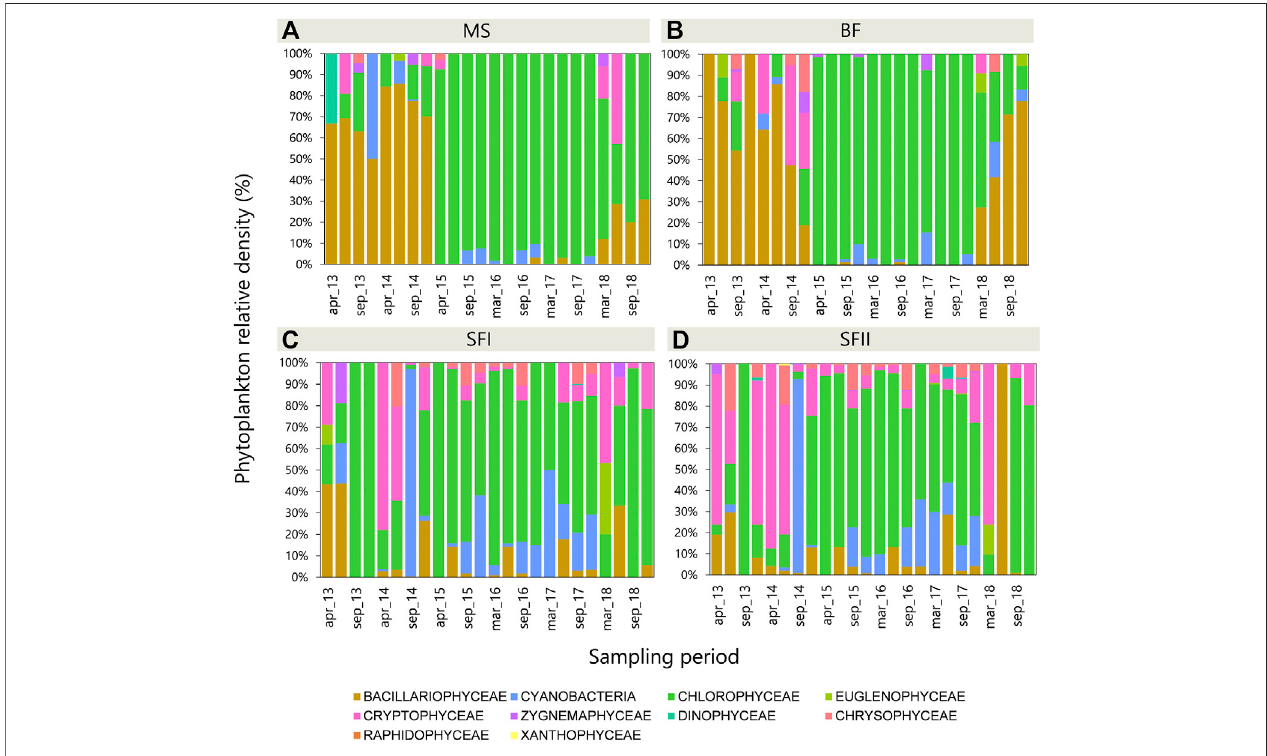
FIGURE 4 | Phytoplankton relative density (%) in the three Small Hydroelectric Power Plant (SHP) reservoirs: (A) Monte Serrat (MS; n = 24), (B) Bonfante (BF; n = 24), (C) Santa Fé I (SF I; n = 24) and (D) Santa Fé II (SF II; n = 24) sampled from 2013 to 2018.